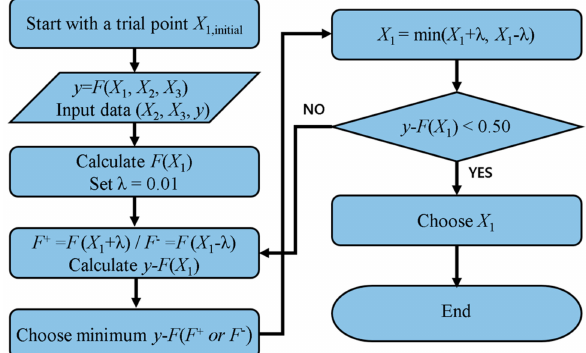
Figure 13. Iterative scheme of the compression condition deduction using the univariate